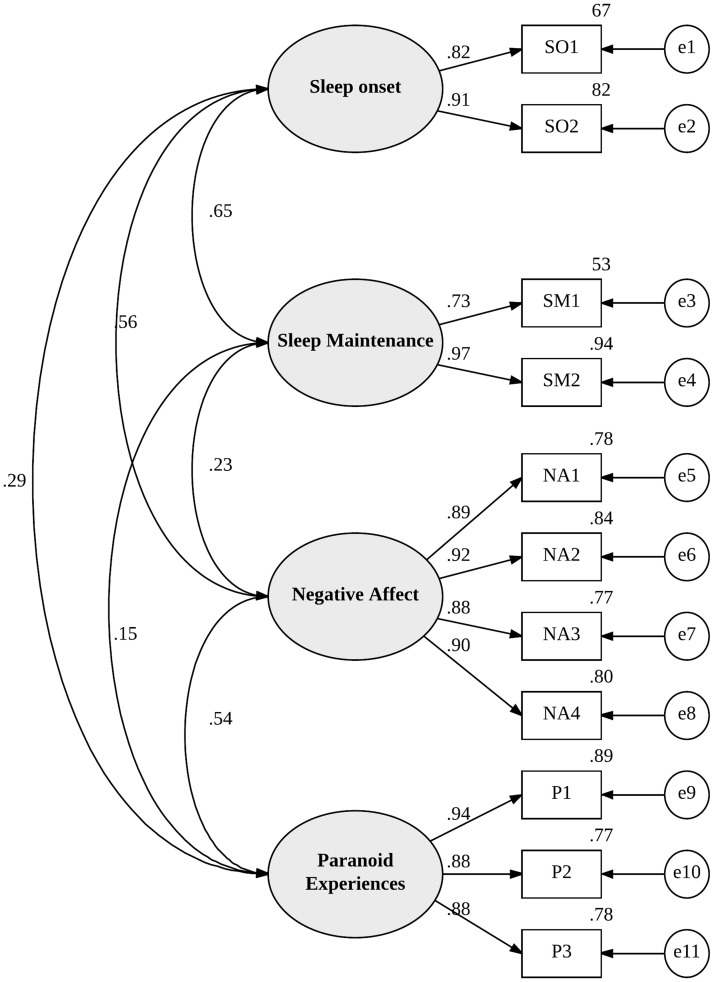
Confirmatory factor analysis.Note: e = error, SO = problems with sleep onset, SM = problems with sleep maintenance, NA = negative affect. P = paranoia. Rectangular boxes represent indicator variables (e.g., items from the DASS-21) that have been parcelled together to form an average (e.g., SO1 and SO2 are parcels consisting of items representing sleep onset), ovals represent latent variables while circles represent error or disturbance.